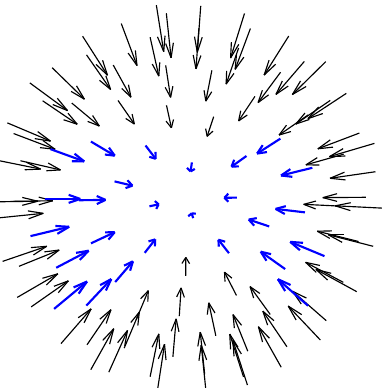
Figure 2. One-hundred light conditions. Synthesized images in the directions indicated by blue arrows are used in the proposed face recognition